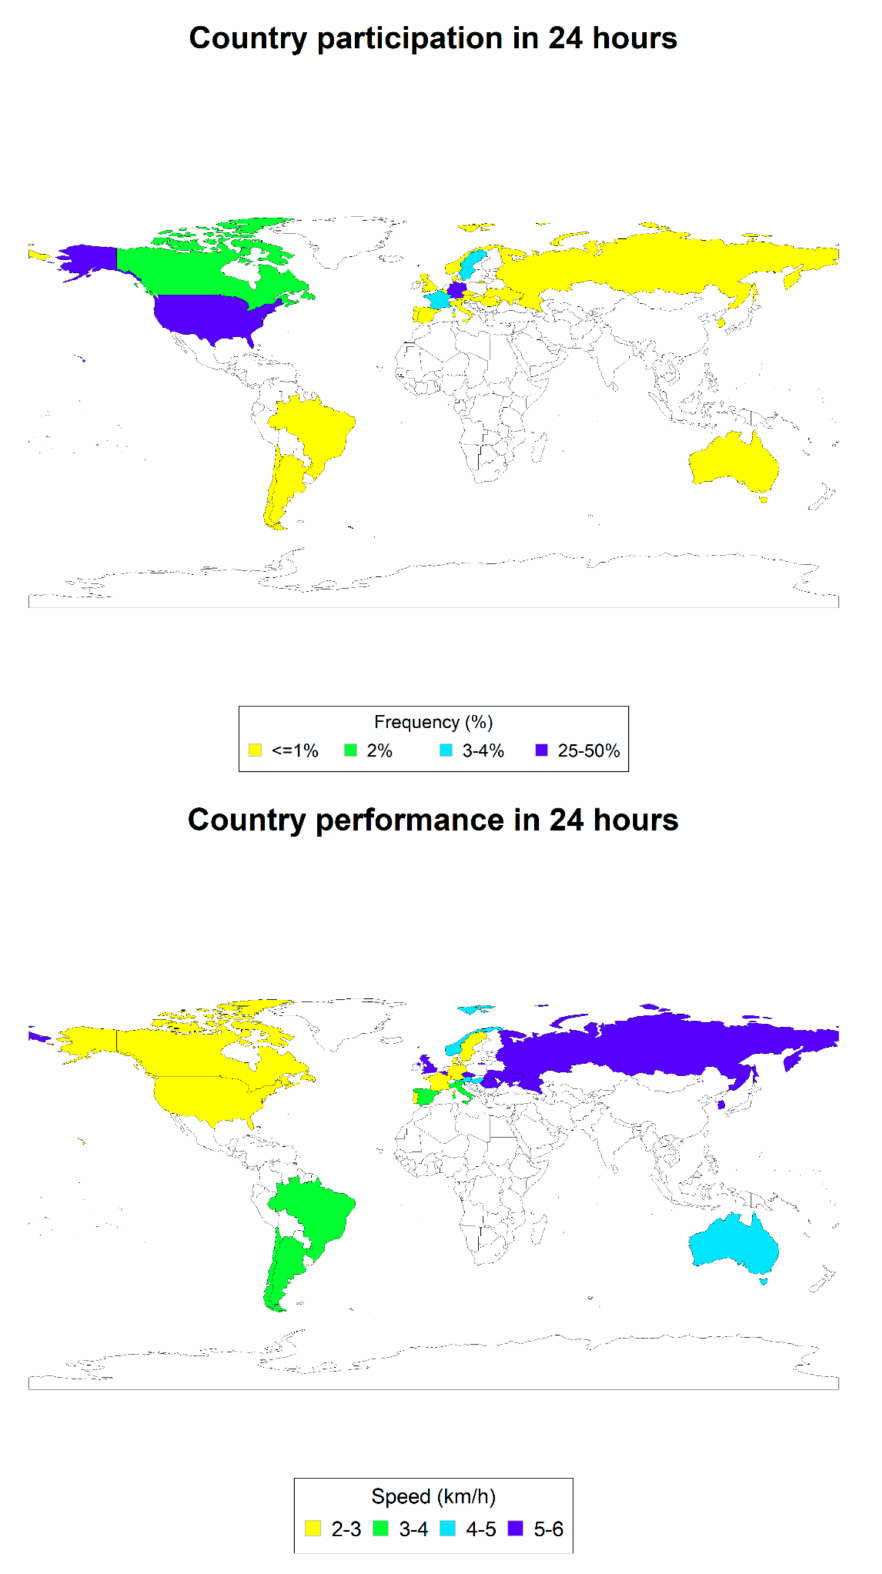
Figure 3. Participation (%) and average performance (km / h) by nationality in 24-h